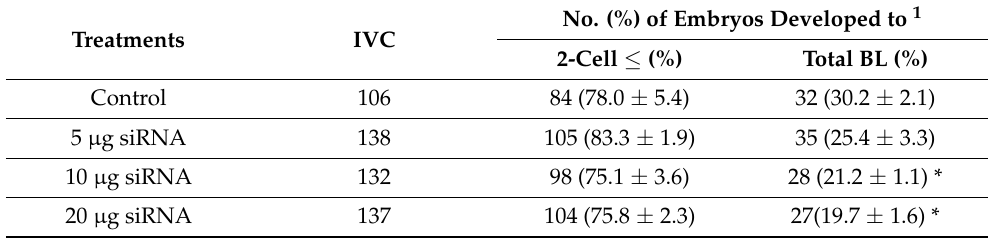
No. (%) of Embryos Developed to 1 2-Cell ≤ (%) Total BL (%)